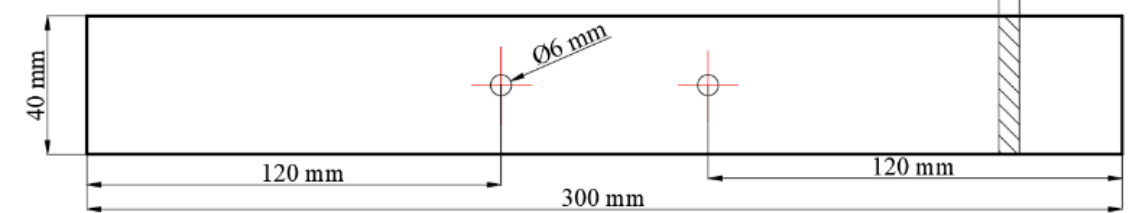
Figure 1. Sample dimensions of DFR base .